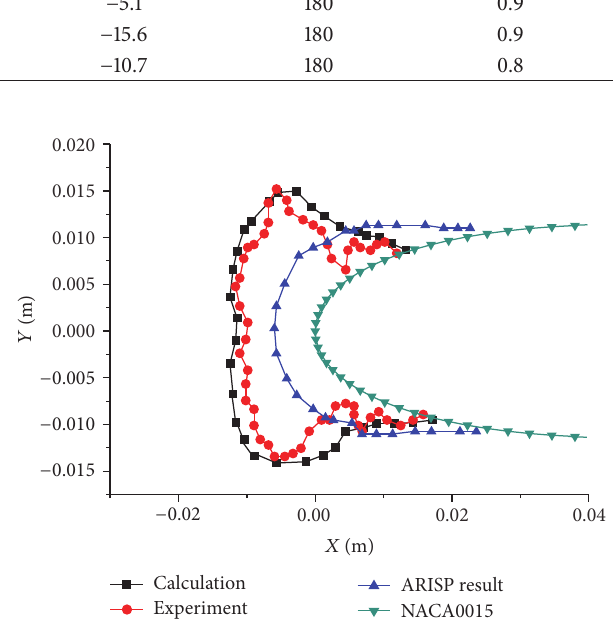
Figure 3: Comparison of rotor blade ice shape in condition 1.